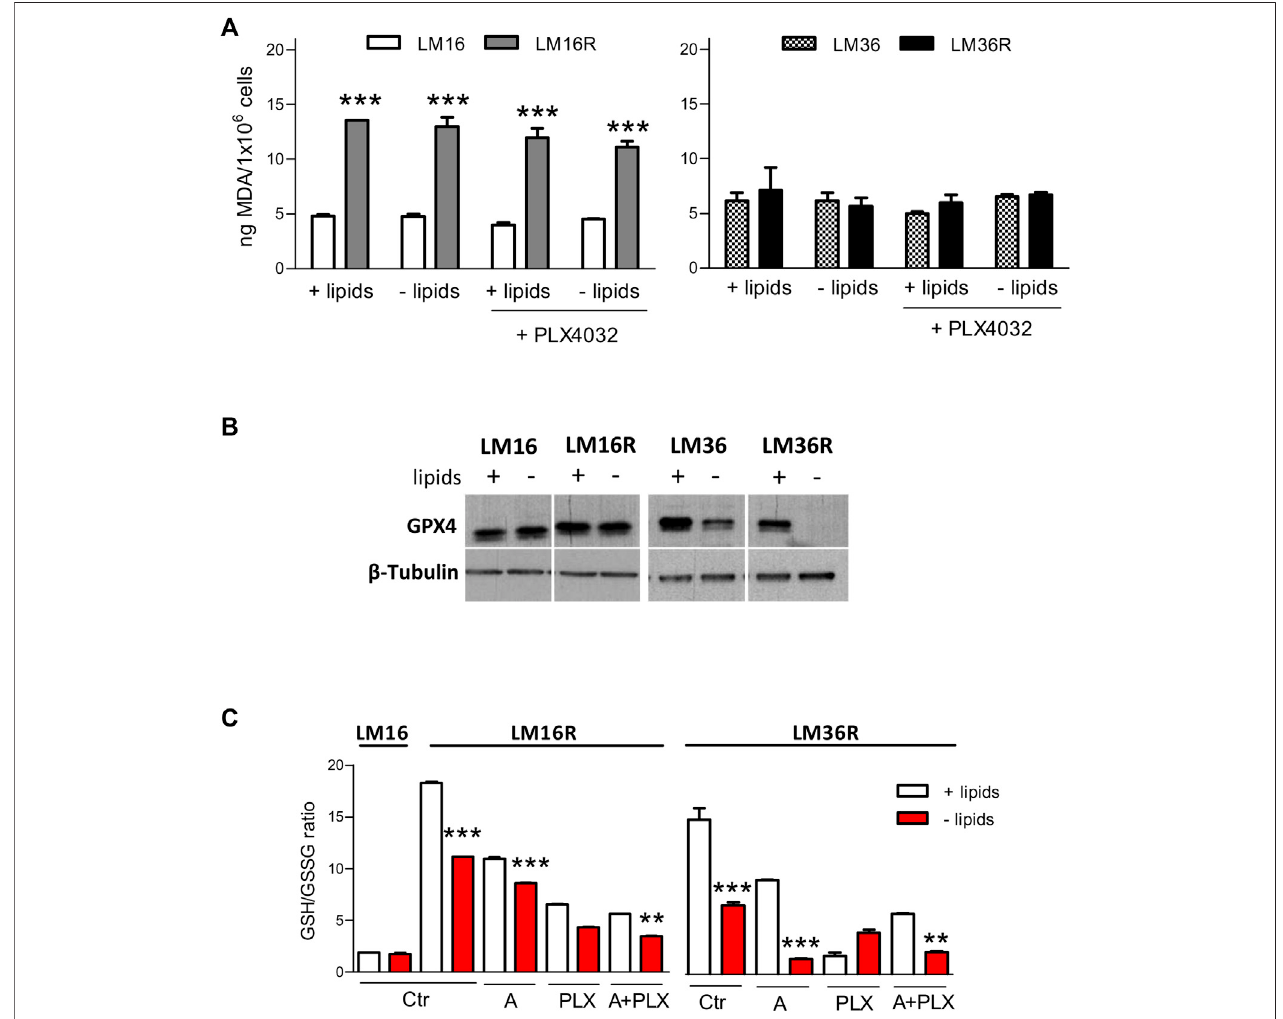
FIGURE7| Effectsoflipidstarvationonferroptosisinmelanomacelllines. (A) .Lipidperoxidationisunaffectedbylipidstarvationinmelanomacells.Inductionoflipid peroxidation as detected by MDA measurement after 24 h culture in standard or in lipid-free medium and after treatment for 24 h with PLX4032 at concentrations correspondingtoIC 80 ascalculatedafter72 hexposure(0.3and0.89 µMforLM16andLM36,respectively;23and13.9 µMforLM16RandLM36R,respectively).*** p < 0.0001 by one-way ANOVA followed by Bonferroni correction. Experiments were repeated twice. (B) . GPX4 expression levels in lysates obtained from LM16, LM16R, LM36, LM36R cells grown for 48 h in the presence or absence of lipids. β – tubulin was used as loading control. (C) . Induction of ferroptosis as detected by reduced GSH/GSSG ratio at 24 h culture in standard or in lipid-free medium after treatment with PLX4032 (3 µM), avasimibe (12.5 µM), alone or in combination. Ctr: untreated control; A: avasimibe; PLX: PLX4032; A + PLX: avasimibe + PLX4032. ** p < 0.01, *** p < 0.0001 by one-way ANOVA followed by Bonferroni